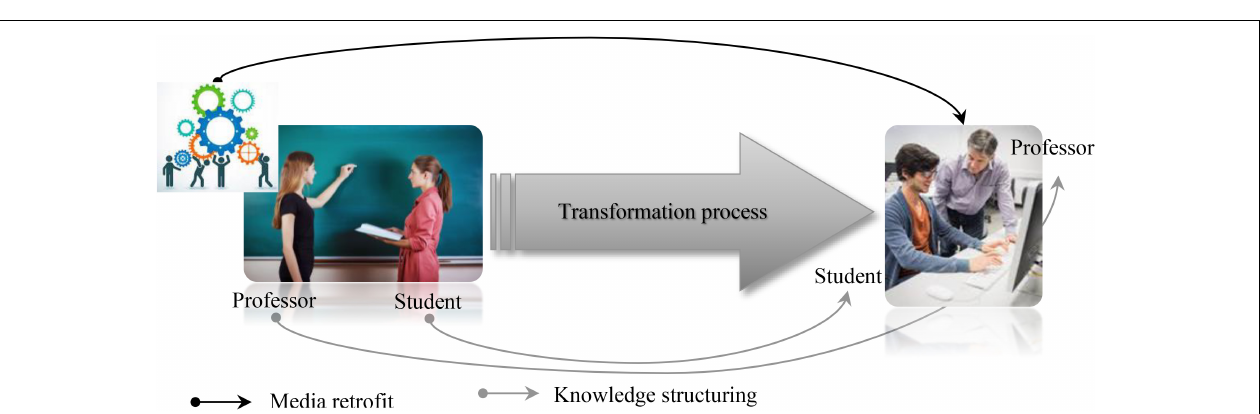
FIGURE 1 | Structural design of the programmatic content generator system for La Universidad del Zulia.